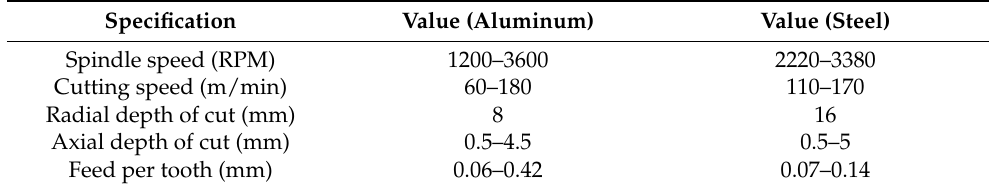
Table 6. Table of